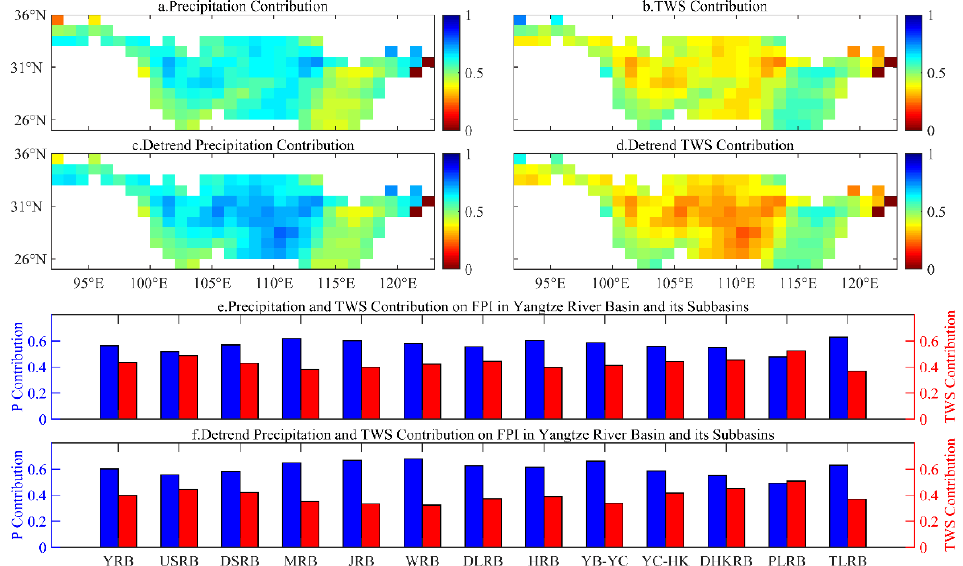
Figure 5. Relative contribution from original and de-trended precipitation and TWSA to FPI in